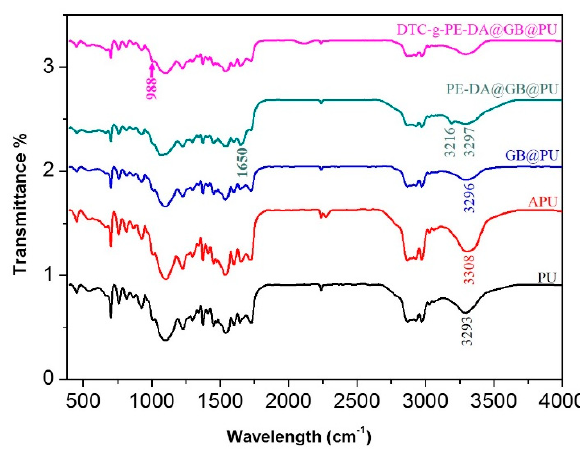
Figure 2. FTIR spectra of ( a ) raw PU, ( b ) APU, ( c ) GB@PU, ( d ) PE-DA@GB@PU, and ( e ) DTC-g-PE-DA@GB@PU.